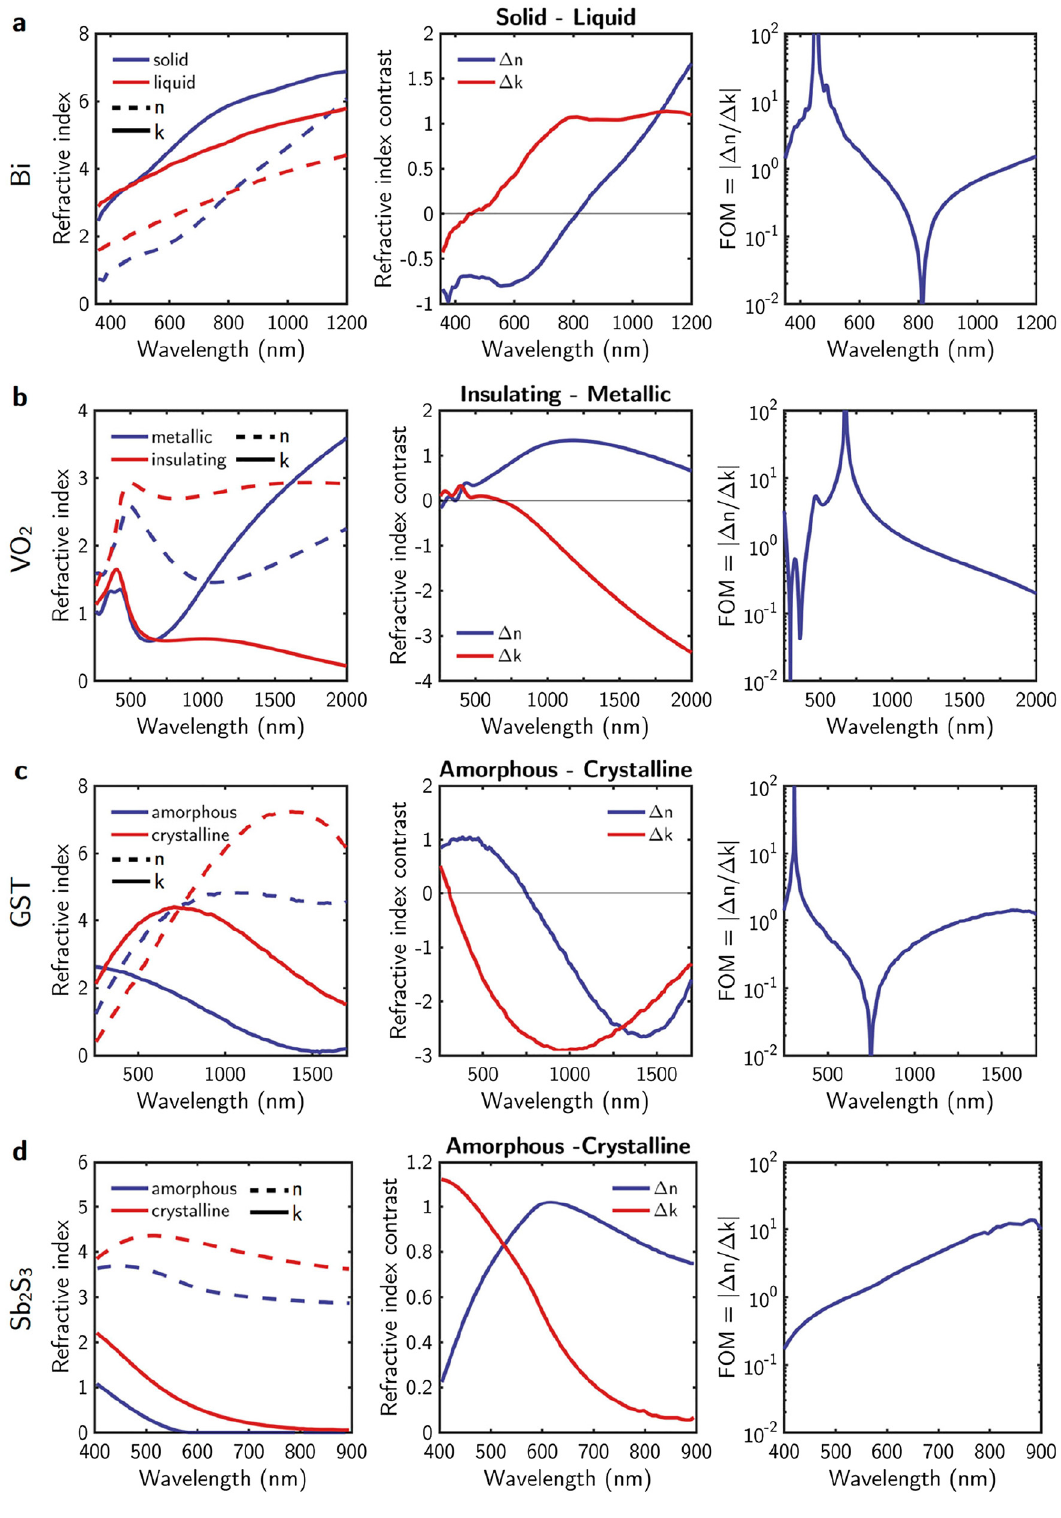
Figure 8: Refractive index ( N = n + ik ), refractive index contrast, and fi gure-of-merit of common PCMs. Complex dielectric function ( fi rst column), refractive index contrast (second column), and FOM = Δ n / Δ k (third column) of (a) Bi [7], (b) VO 2 [17], (c) Ge 2 Sb 2 Te 5 (GST) [9], and (d) stibnite (Sb 2 S 3 ) [12]. PCM, phase-change material; VO 2 , vanadium